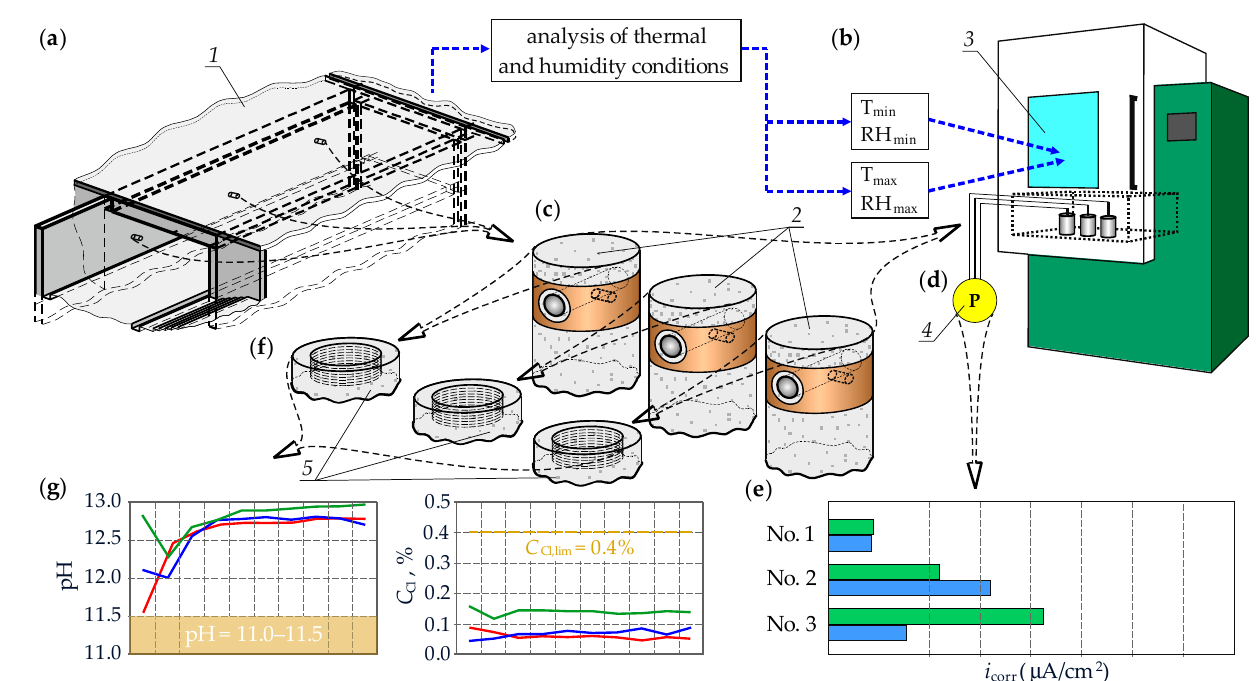
Figure 3. Methodology of measuring corrosion rate of reinforcement in drilled concrete cores by simulating thermal and humidity conditions in the climate chamber: ( a ) drilling cores for corrosion tests and analysis of thermal and humidity conditions for the structure; ( b ) determination of extreme temperature and relative humidity values taken for corrosion testing of core specimens; ( c ) drilled cores equipped with three solid electrodes; ( d ) polarization measurements on the specimens in the climate chamber using the potentiostat; ( e ) values i corr obtained in the climate chamber for extreme thermal and humidity conditions; ( f ) grinding layers of concrete cover; ( g ) profiles of chloride ion concentrations and concrete pH; 1—the tested structure, 2—specimens of concrete cores with three fixed electrodes, 3—climate chamber, 4—potentiostat, 5—concrete cover subjected to grinding by